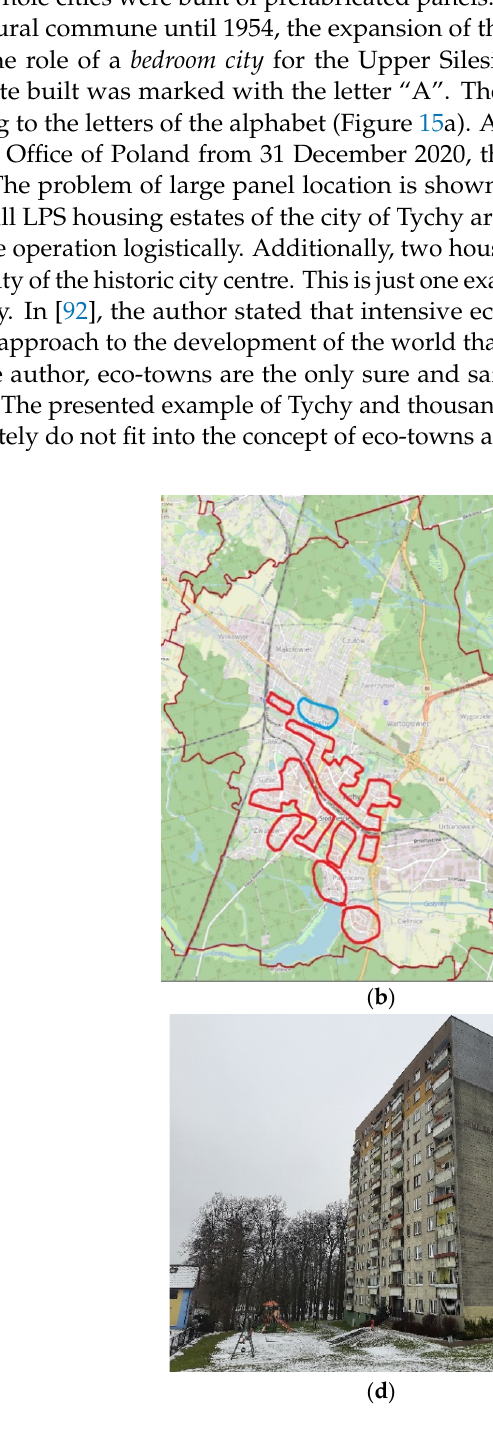
Figure 15. Example of LPS technology in Tychy, Poland: ( a ) housing estates built in 1950–1990. The letters of the alphabet stand for the names of the estate [93] ( b ) administrative borders of the city in 2022. The red colour shows housing estates from ( a ), blue colour indicates the historical centre [94] ( c , d ) estate O buildings .